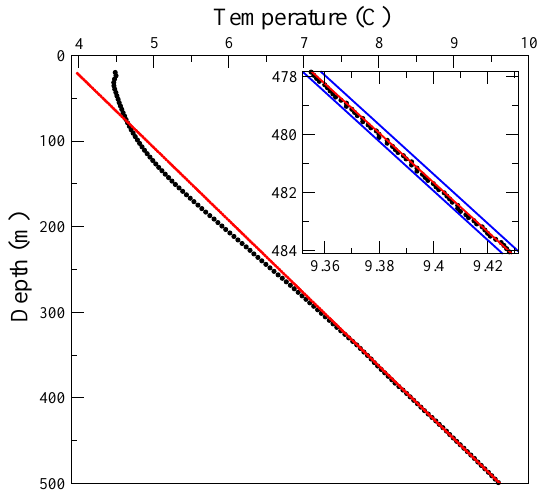
Fig. 8. Subsurface temperature anomalies estimated from the Minchin Lake temperature-depth profile after truncating the tem- perature log at different depths. The legend indicates the truncation depth of the profile used to calculate each of the temperature anoma- lies shown.